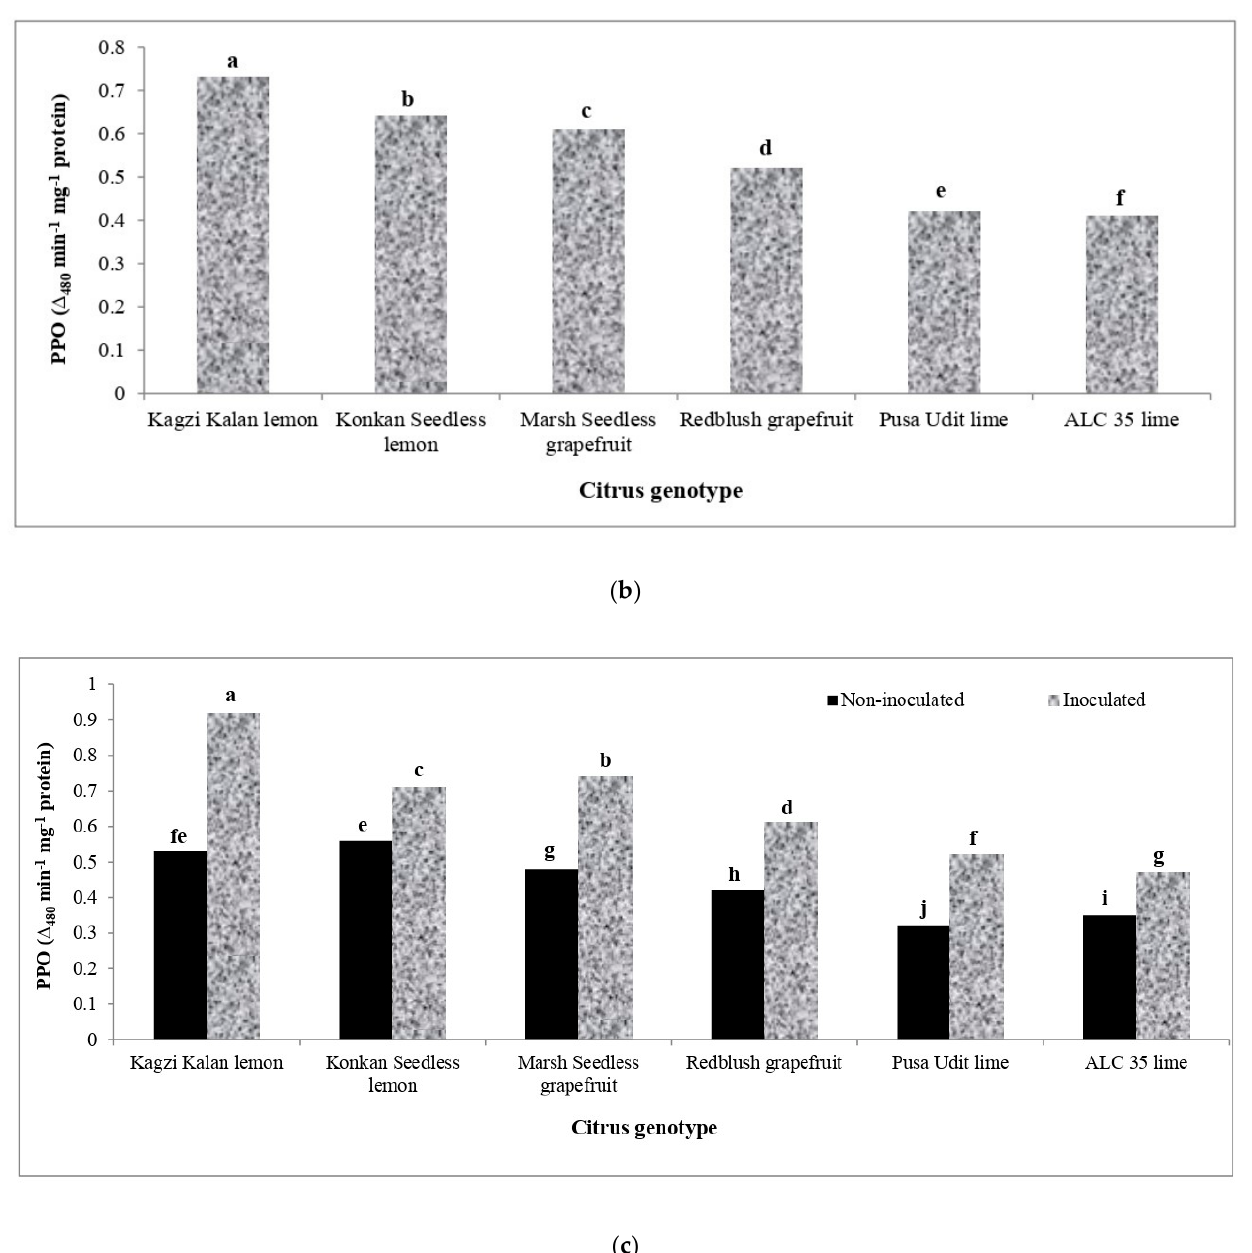
Figure 5. Effect of X. citri pv . citri (Xcc) on the polyphenol oxidase (PPO) enzyme activity in Citrus spp. ( a ) The activity of PPO in Xcc inoculated and mock-inoculated plants. ( b ) Mean activity of PPO in different citrus genotypes. ( c ) The interaction effect of Xcc on PPO activity in inoculated and non-inoculated plants. Means for inoculation, genotypes and their interaction followed by different lowercase letters are significantly different at p ≤ 0.05 by Tukey’s HSD test.